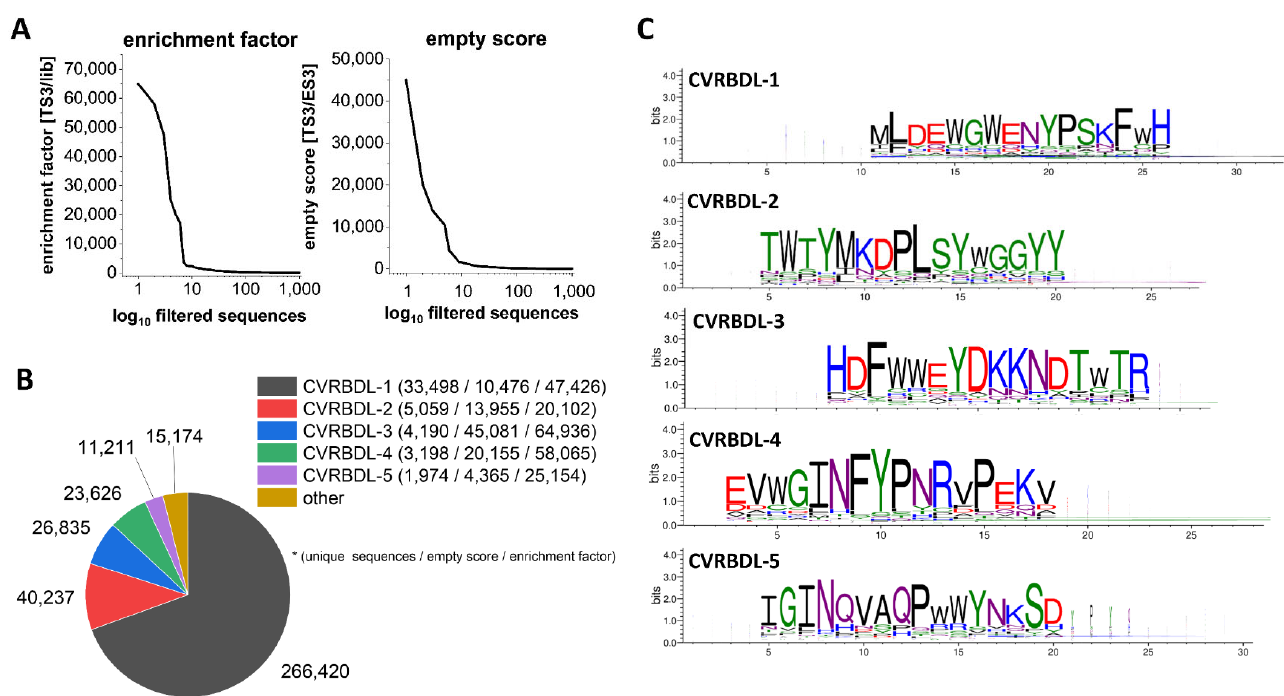
Figure 2. NGS sequence filtering and clustering reveals five main sequence motifs. ( A ) Evaluation of the enrichment factors (TS3/lib) and empty scores (TS3/ES3) of the first 1000 sequences as ranked by their enrichment factor or empty score, respectively. Sequences were filtered according to their enrichment on the target (lib > TS1 > TS2 > TS3), their frequency in the target selection as compared to the empty selection (TS1 > ES1; TS2 > ES2; TS3 > ES3) as well as their frequency decrease when the target selection was subjected to a surface without target (TS2 > DC2; TS3 > DC3). ( B ) Cluster distribution of the filtered sequences after three consecutive rounds of cluster extension and merging. The pie chart depicts the total number of sequences that were assigned to one cluster including multiple occurrences of identical sequences. The legend shows the number of unique sequences that were assigned to each cluster. Additionally, for each main sequence of the cluster, the specific empty score and enrichment factor is listed. ( C ) Conserved cluster motifs resulting from cluster assignments as shown in ( B ) derived by Hammock clustering software.